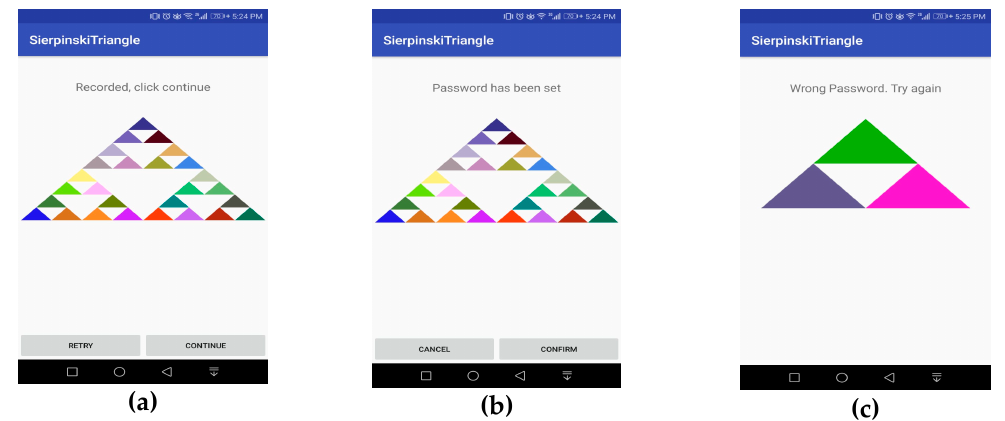
Table 1. Password space of proposed technique up to level 5.